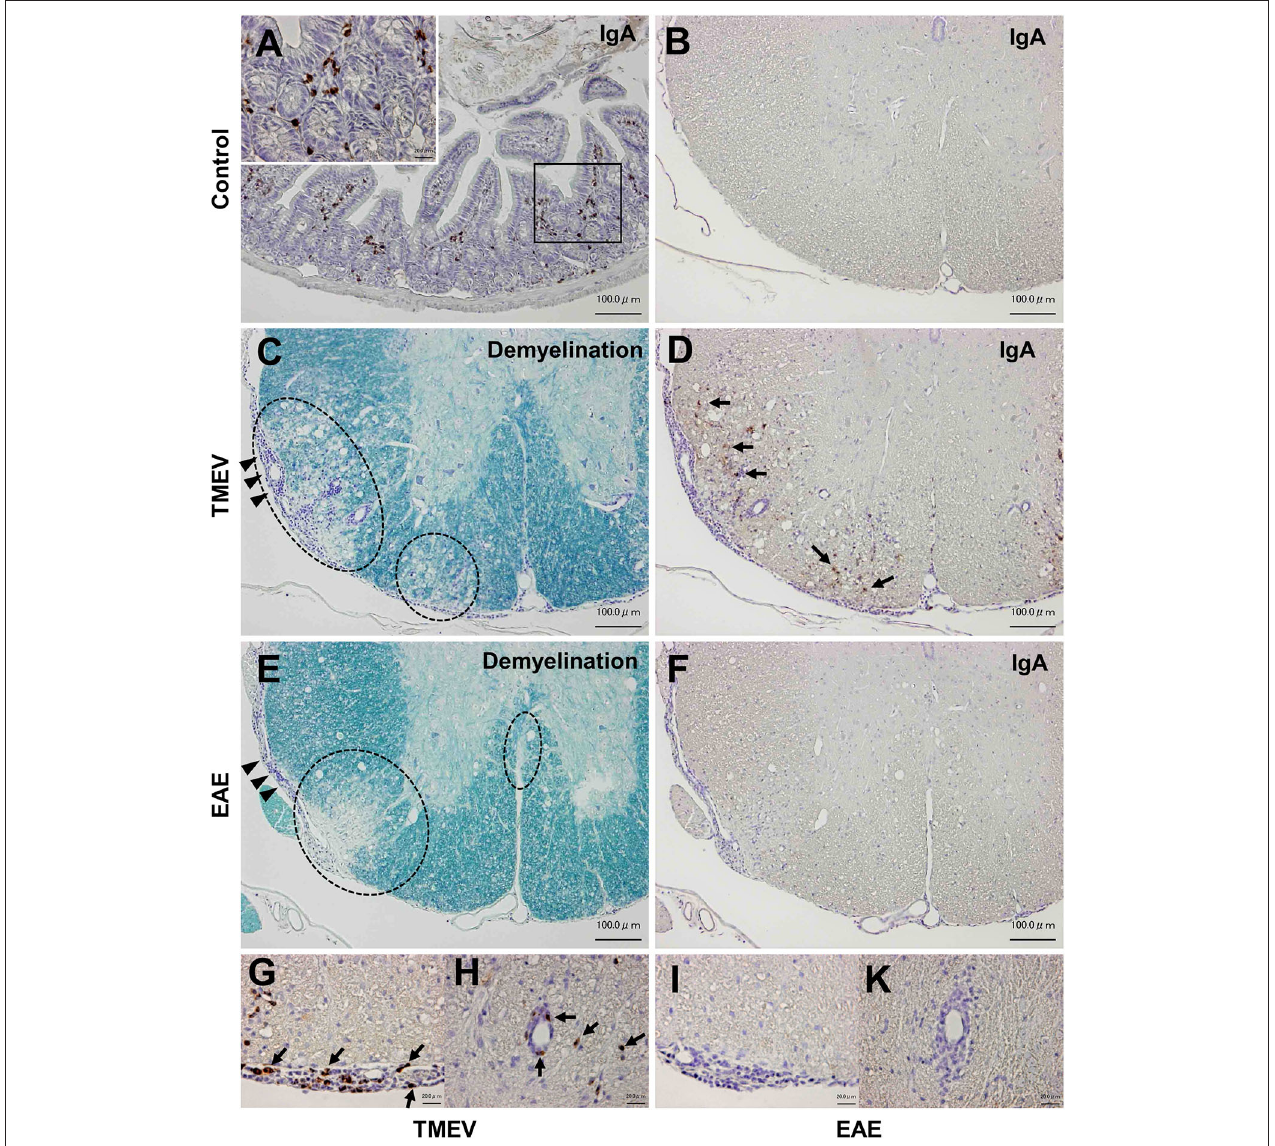
FIGURE 8 | IgA immunohistochemistry in inflammatory demyelinating lesions in two models for multiple sclerosis. (A) We used IgA-producing cells in the lamina propria of the small intestine from uninfected control mice as positive controls for IgA immunohistochemistry. (B) In control mice, we did not detect IgA-positive cells in the spinal cord. (C,D) During the chronic phase of TMEV infection, inflammatory demyelinating lesions were present in the white matter of the spinal cord, where IgA strongly positive cells (arrows) were present in demyelinating parenchyma (D) , meningitis (G) , and perivascular cuffing (H) . IgA deposition was also observed in demyelinating lesions (D) . (E,F) Chronic inflammatory demyelinating lesions in the white matter of the spinal cord in experimental autoimmune encephalomyelitis (EAE) induced with myelin proteolipid protein (PLP). Despite the presence of inflammatory demyelination, there was no IgA immunoreactivity in the parenchymal (F) , meningeal (I) , or perivascular (K) inflammatory lesion of the spinal cord. Scale bar = 100 µ m (A–F) and 20 µ m (G–K) . (A,B,D,F–K) , IgA immunohistochemistry. (C,E) , Luxol fast blue stain. Dotted lines, demyelinating lesions. Arrowheads, meningitis. These sections are representative of naive, TMEV-infected, or EAE mice ( n = 3–5 per